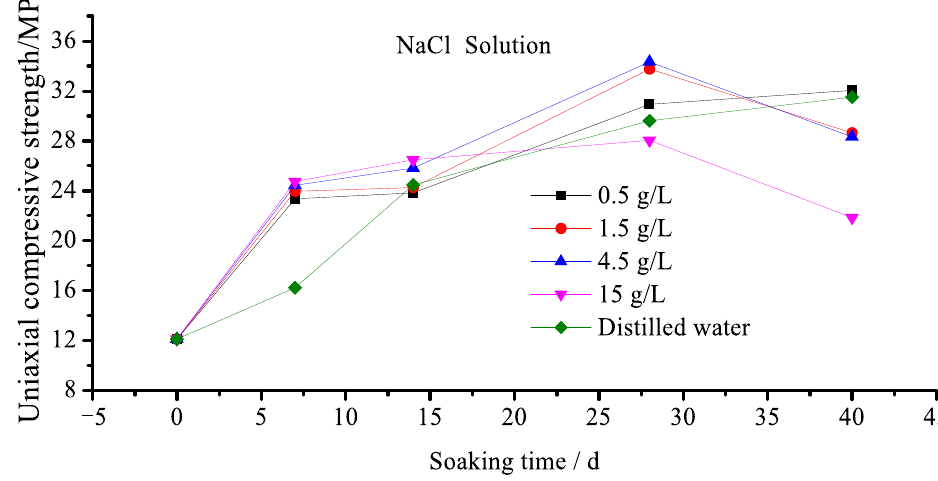
Figure 2. Uniaxial compressive strength of paste backfill specimens when submerged in different concentrations of chloride solution according to soaking time.